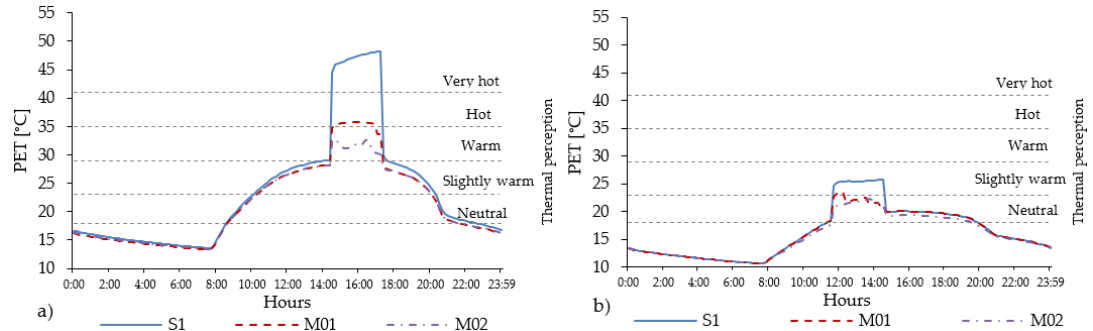
Figure 16. Evolution of PET level in open-set high-rise urban area for scenarios S1, M01 and M02 in R04, located in the middle of the UC for the worst NE-SW ( a ) and the best NW-SE ( b ) orientations.